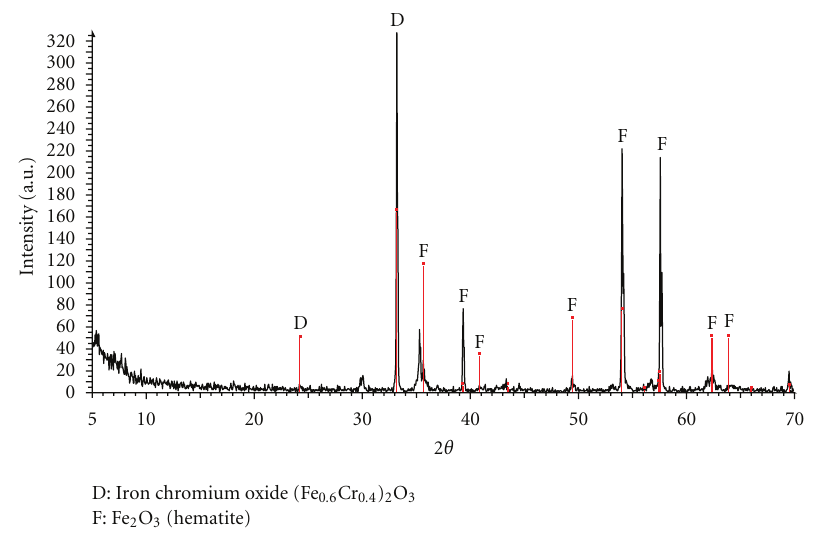
Figure 3: X-ray di ff raction image for AISI 304 stainless steel oxidized in synthetic air at T = 1000 ◦ C.